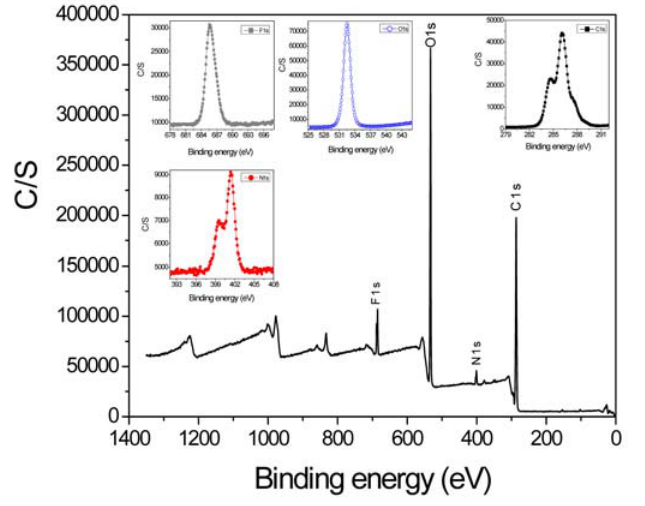
Figure 7. XPS survey spectra of ionic liquid-PPy-cellulose hybrid nanocomposite: insets show the detailed C1s, N1s, O1s and F1s